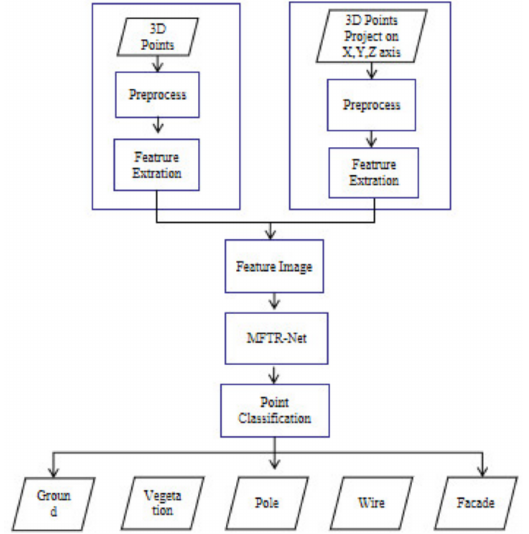
Figure 4. Flow chart of point cloud classification using